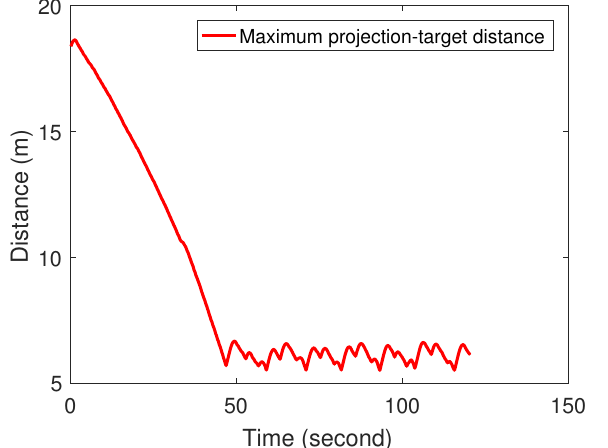
Figure 8. The maximum projection–target distance of the simulation in Figure 7. A video for this example is available at: https://youtu.be/coQgGKb18g4 (accessed on 11 September